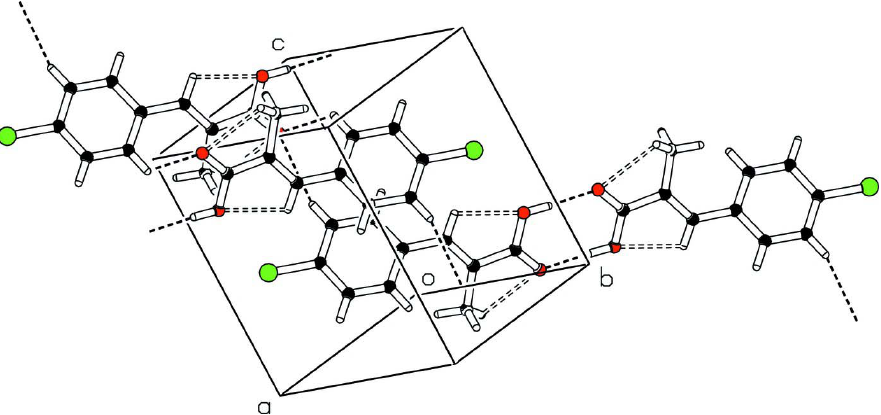
Figure 1 ORTEP drawing of (I) with the atom numbering scheme. The thermal ellipsoids are drawn at the 50% probability level. The intramolecular H-bonds are shown by doted lines.